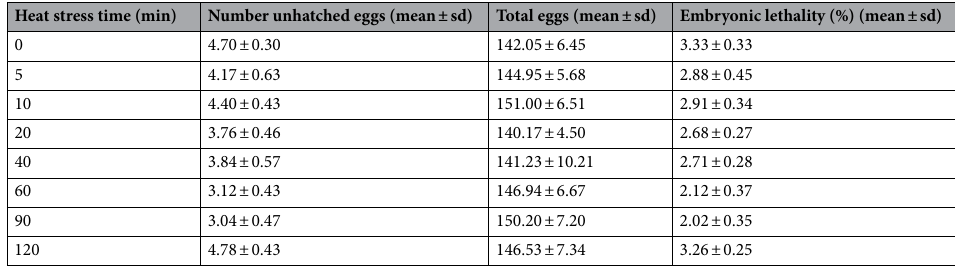
Table 1. Embryonic lethality of top worms after laying eggs for 36 h.